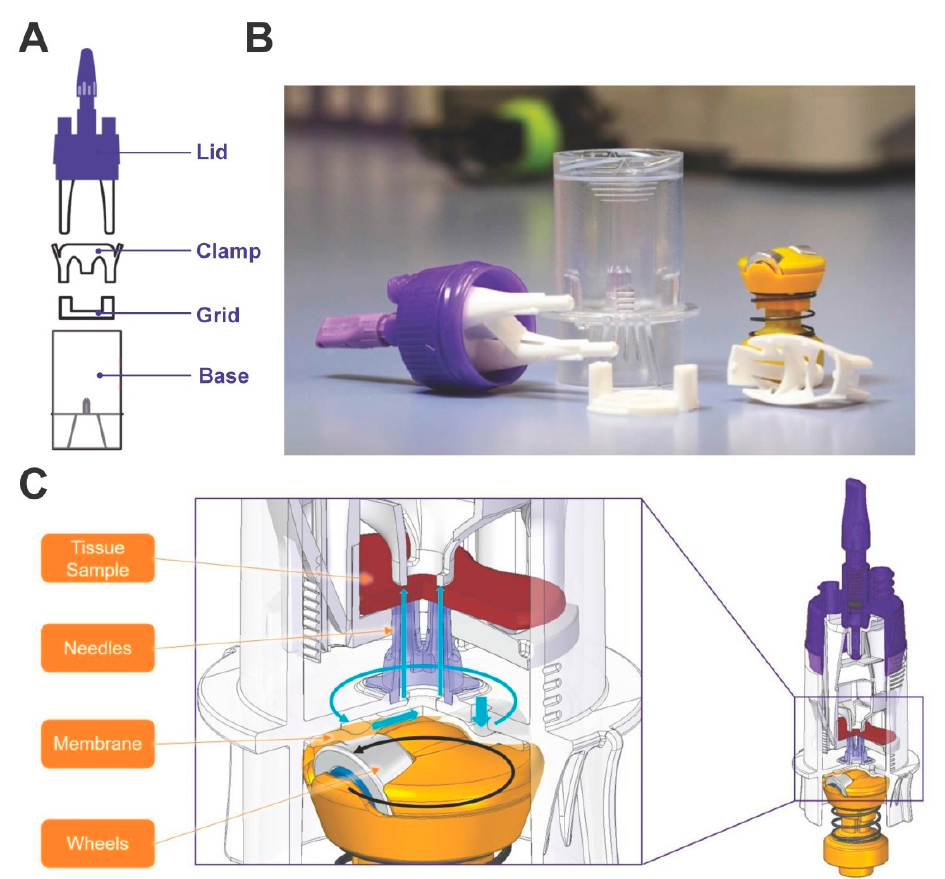
Figure 1. The gentleMACS Perfusion Technology. ( A – C ) The Perfuser can be disassembled into four parts, i.e., the Lid, Clamp, Grid, and Base. The Base contains an in-built peristaltic pump which delivers liquids via a needle array into the penetrated liver sample. To aspirate buffer from the inside of the Perfuser, a Pasteur pipette with an elongated tip is introduced through one of the Luer-lock connectors to the Base bottom. The Adjuster on top of the Lid can be used to adapt the penetration depth of the needle array into the liver tissue.